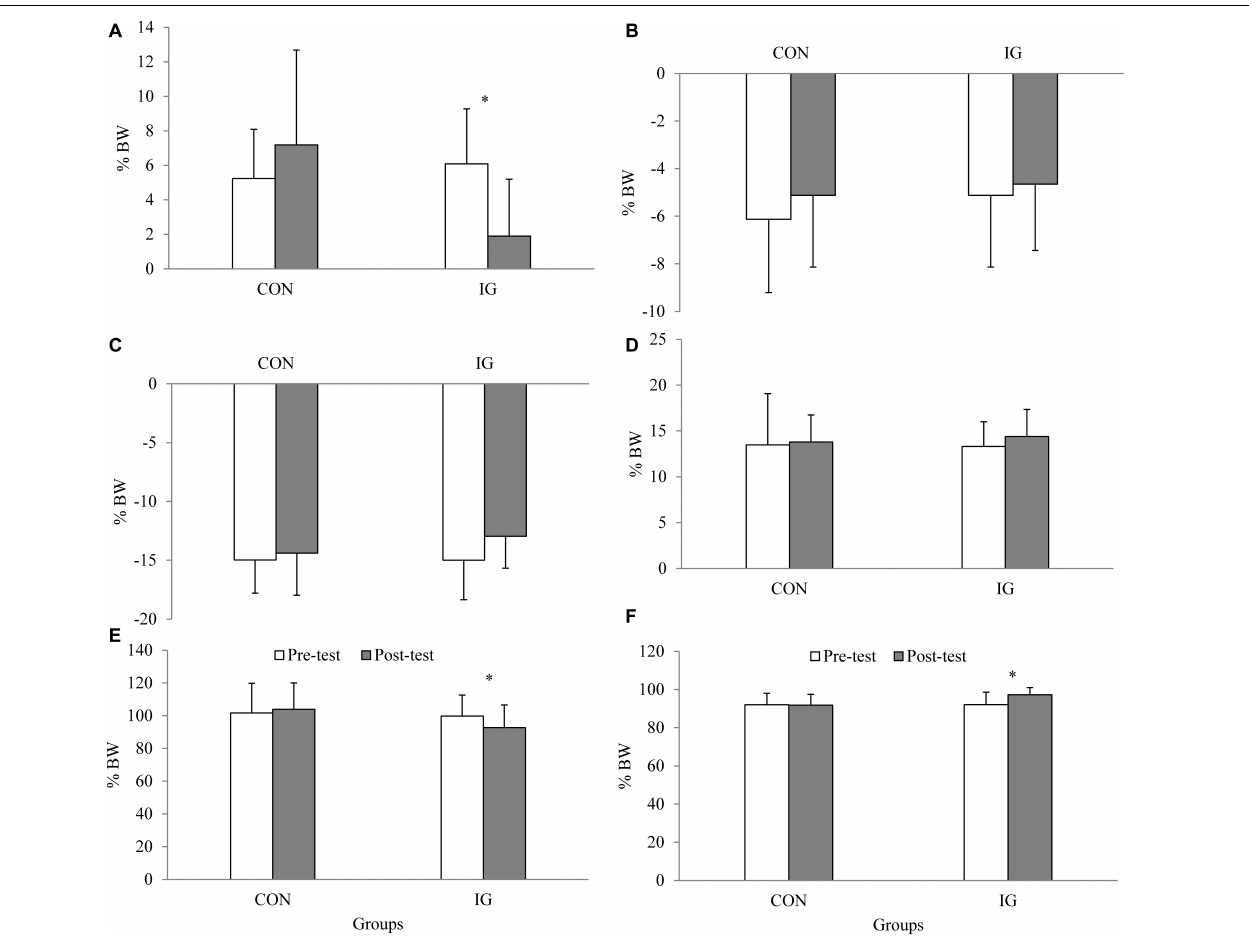
FIGURE 2 | Data are presented as means and standard deviations and illustrate group-specific ground reaction forces during walking at constant speed (1 m/s) before and after training. IG, intervention group; CON, control group; BW, body weight; (A) FxHC, peak lateral ground reaction force at heel contact; (B) FxPO, peak medial ground reaction force during push-off; (C) FyHC, braking reaction force; (D) FyPO, propulsion force; (E) FzHC; first peak of vertical ground reaction force at heel contact; (F) FzPO, vertical ground reaction force during